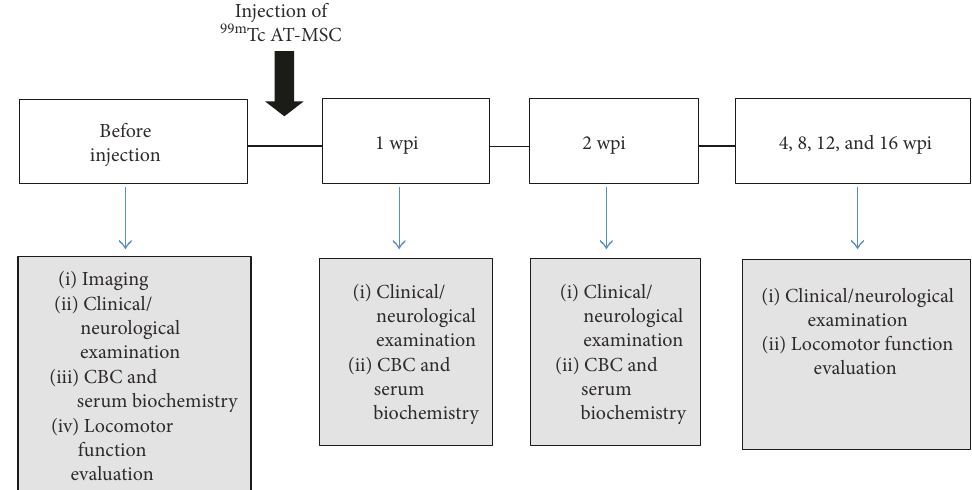
Figure 1: Experimental design. Chronogram of the experimental procedures carried out before and after injection of 99m TC AT-MSCs. CBC, complete blood count; wpi, weeks